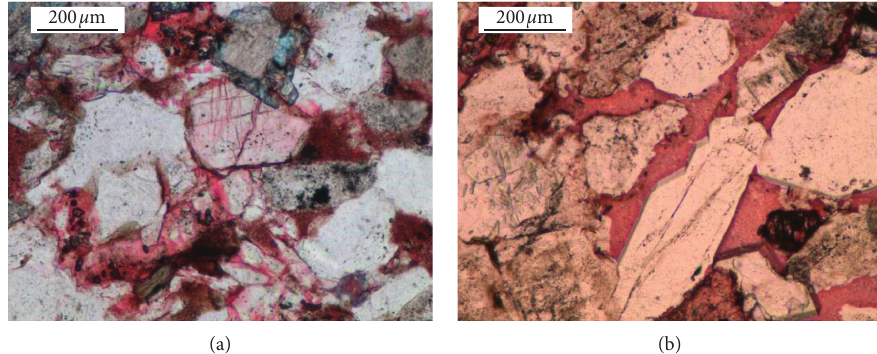
Figure 6: Throat types of Chang 2 reservoir in the study area. (a) Flake throat (N39, 1218.6m) and (b) necking throat (Z48, 1291.1m).